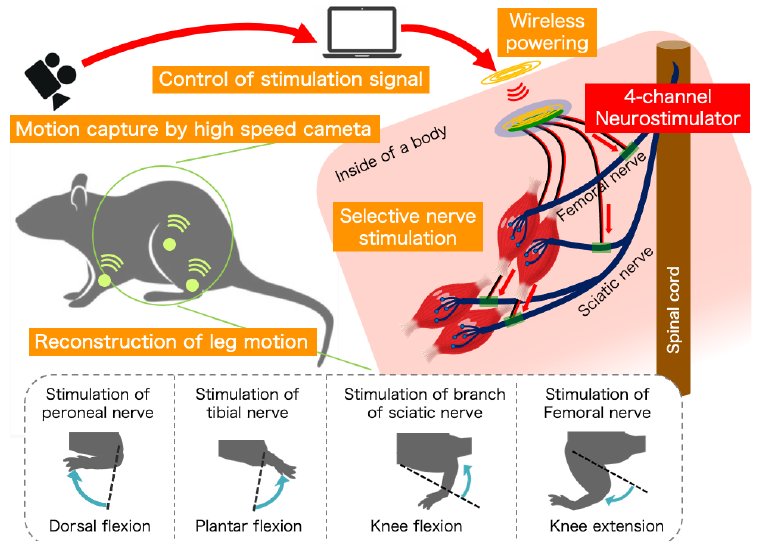
Figure 1. A schematic of the concept of the multi-channel neurostimulator to stimulate peripheral nerves using visual feedback control to reconstruct functional motions; rat leg motion can be con- trolled by changing the stimulated nerve, and the stimulation can be controlled by a visual feedback system using a high-speed camera.